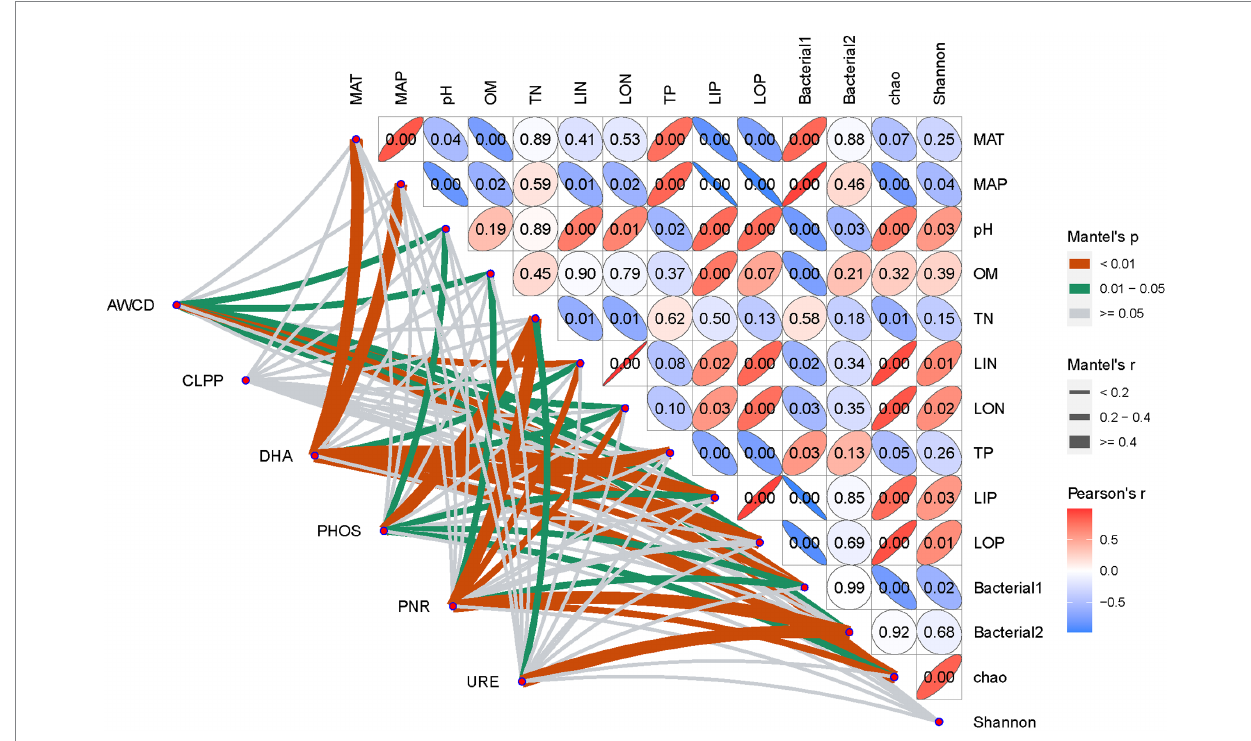
FIGURE 7 Dependence of soil multifunctionality on soil environmental factors and bacterial communities on Mantel test